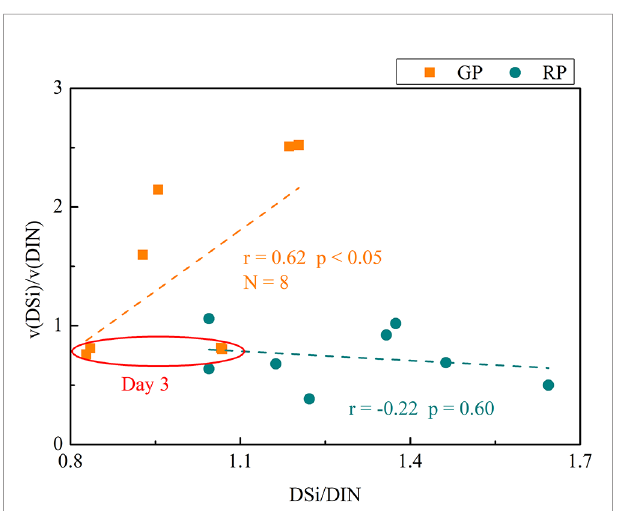
FIGURE 3 | The relationship between DOC concentration and POC concentration in different algae phases of the four